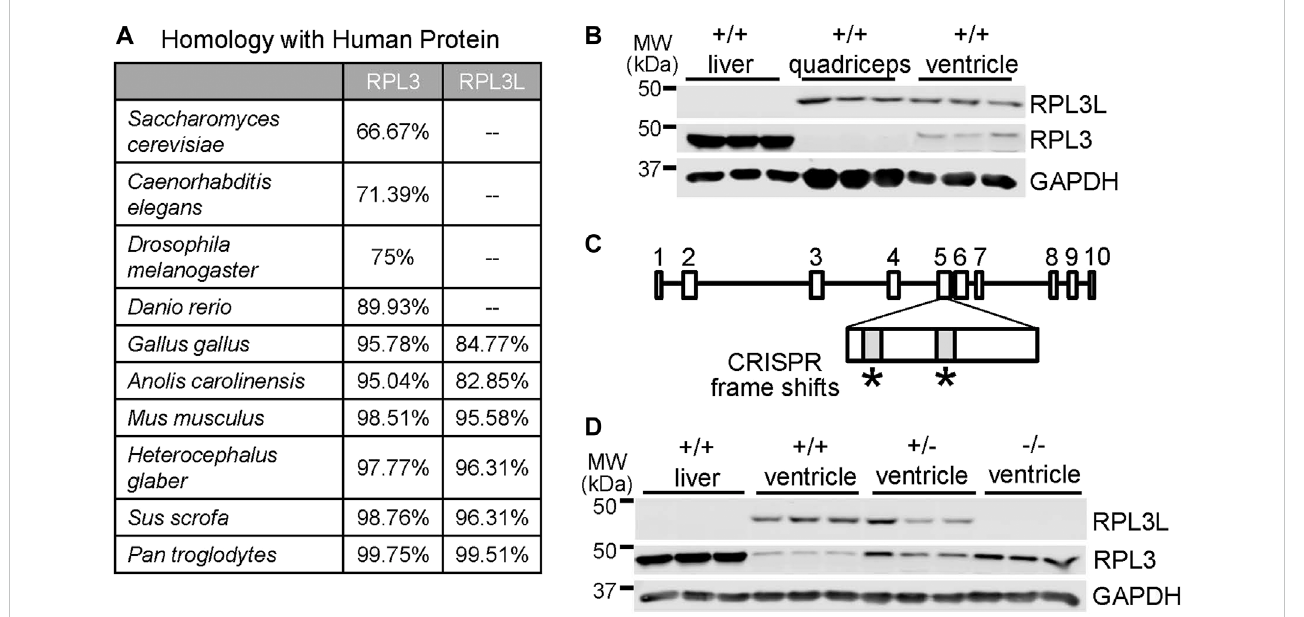
FIGURE 1 Generationof Rpl3l gene-deleted mice. (A) Table showing evolutionary amino acid sequence conservation as percentage identity for human RPL3L and RPL3 generated from sequences in the NCBI database. (B) Western blot showing RPL3L versus RPL3 in adult liver, quadriceps skeletal muscle and heart ventricles at 2 months of age. GAPDH was used as a control for tissue processing and blotting ( n = 3 in each group). MW denotes molecular weight in kilodaltons (kDa). (C) Schematic of the mouse Rpl3l gene locus and CRISPR strategy utilized to target two areas of exon fi ve to induce a frameshift and subsequentdeletionmutation. (D) WesternblottingofRPL3LandRPL3fromliverorcardiacventriclesofwildtype(+/+), Rpl3l +/ − and Rpl3l − / − mice,con fi rming loss of RPL3L protein in the hearts of the − / − (nullizygous) CRISPR targeted